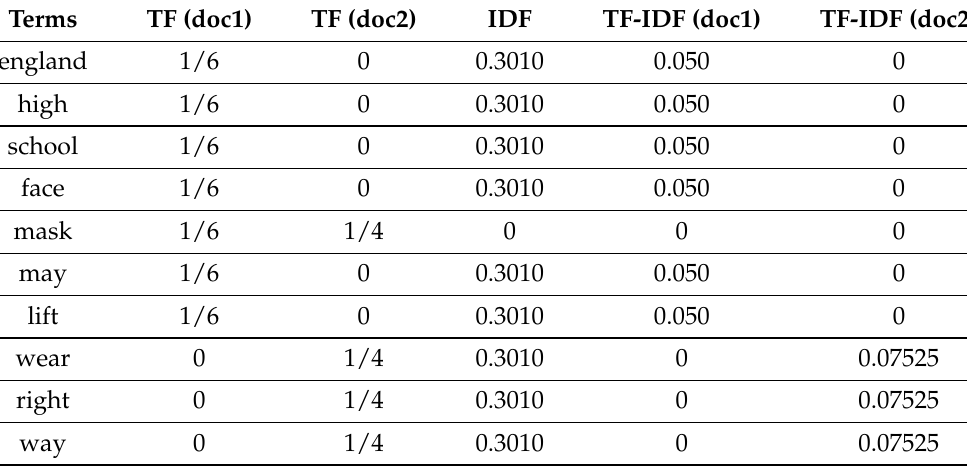
Table 7. TF-IDF features on preprocessed data taken from the